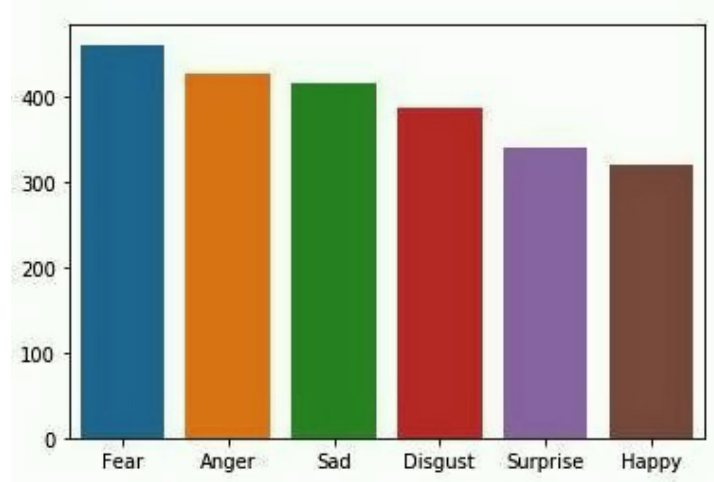
Figure 4. Review count based on polarity.